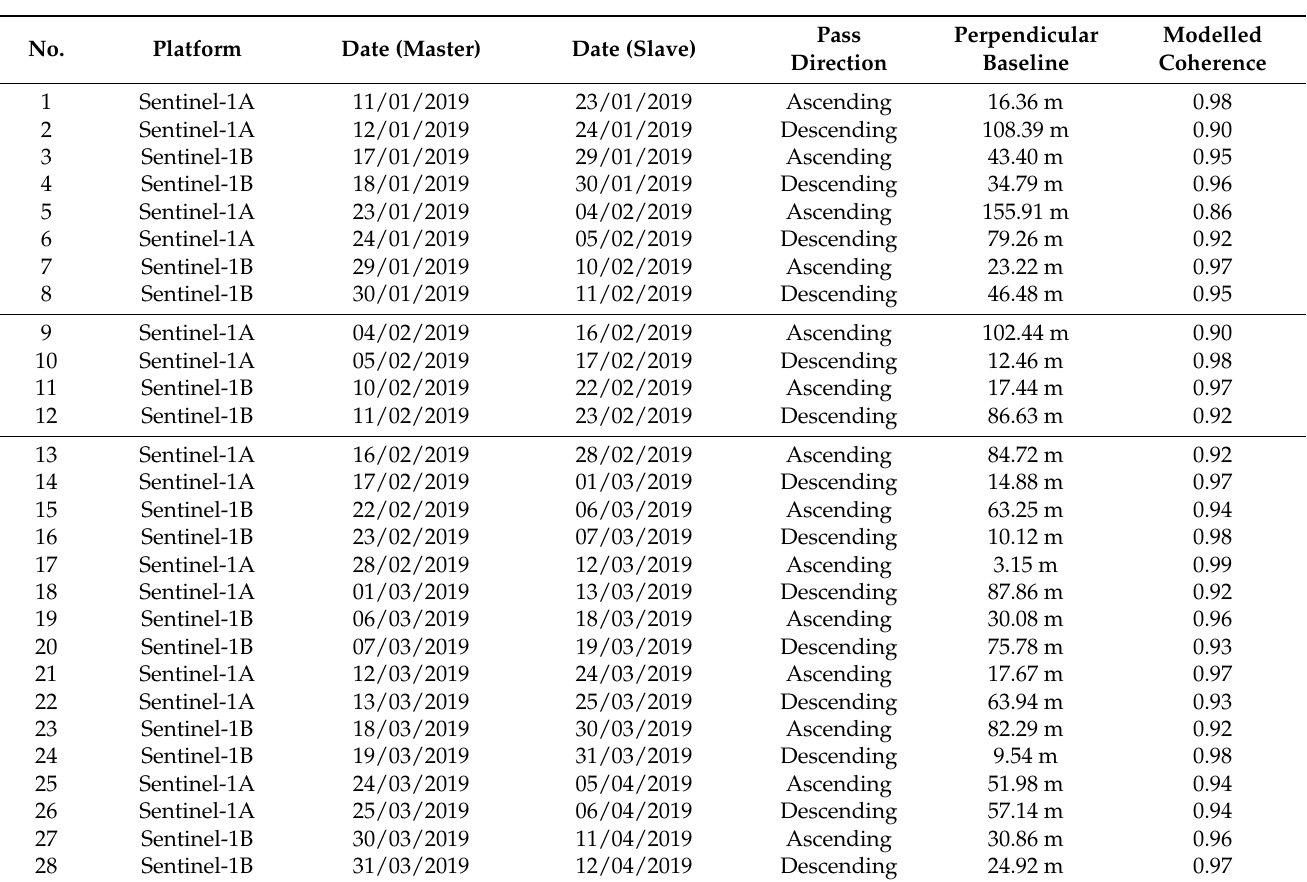
Table 2. SAR image interferometric pairs [29]. Image pairs 1–8 are in the pre-event, 9–12 are in the co-event, and 13–28 are in the post-event